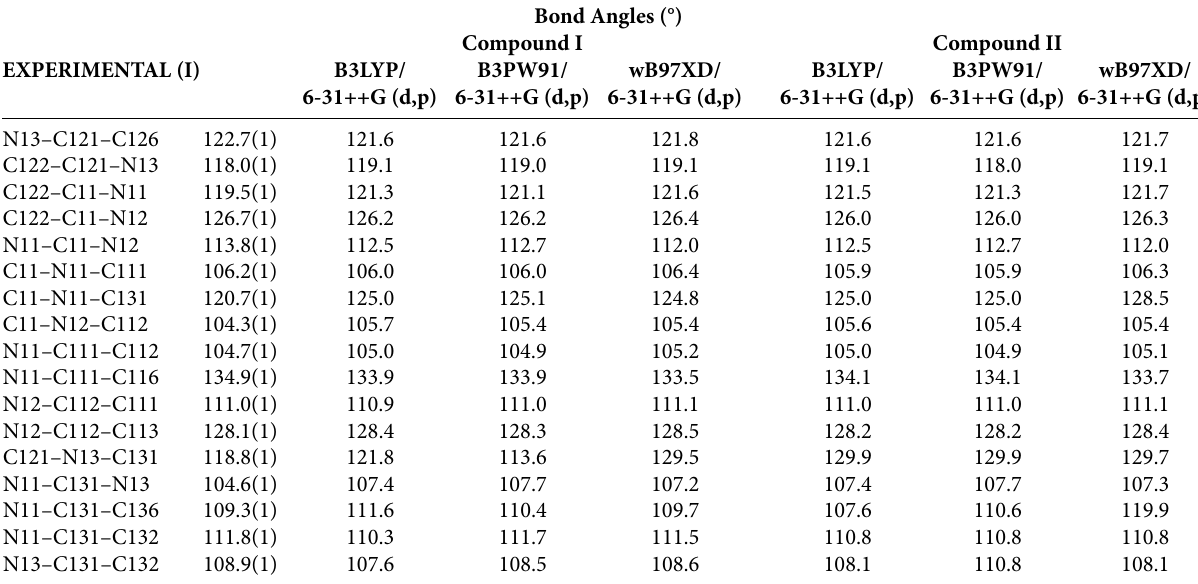
Table 2. Summary of theoretical and experimental bond angles of 4-methylcyclohexanone derivative as well as the computed bond angles of 3-methylcyclohexanone